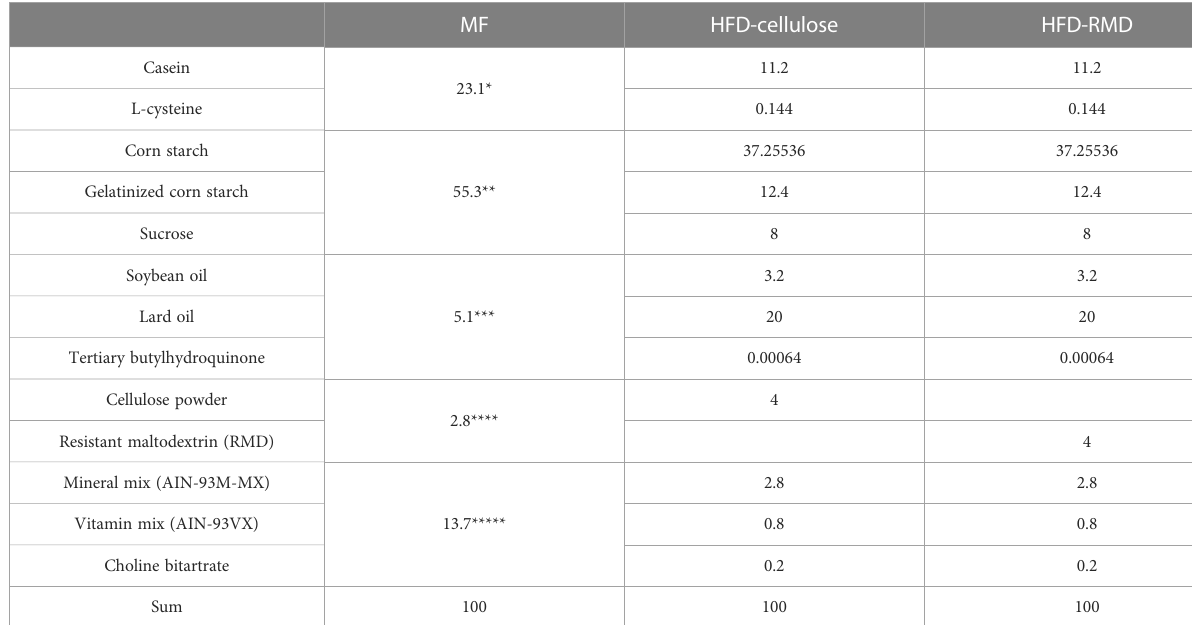
TABLE 1 Ingredients of the diets